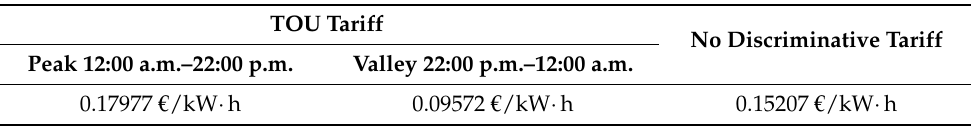
Table 5. Considered Time of Use (TOU) and no discriminative tariff for the economic study of the Model Predictive Control